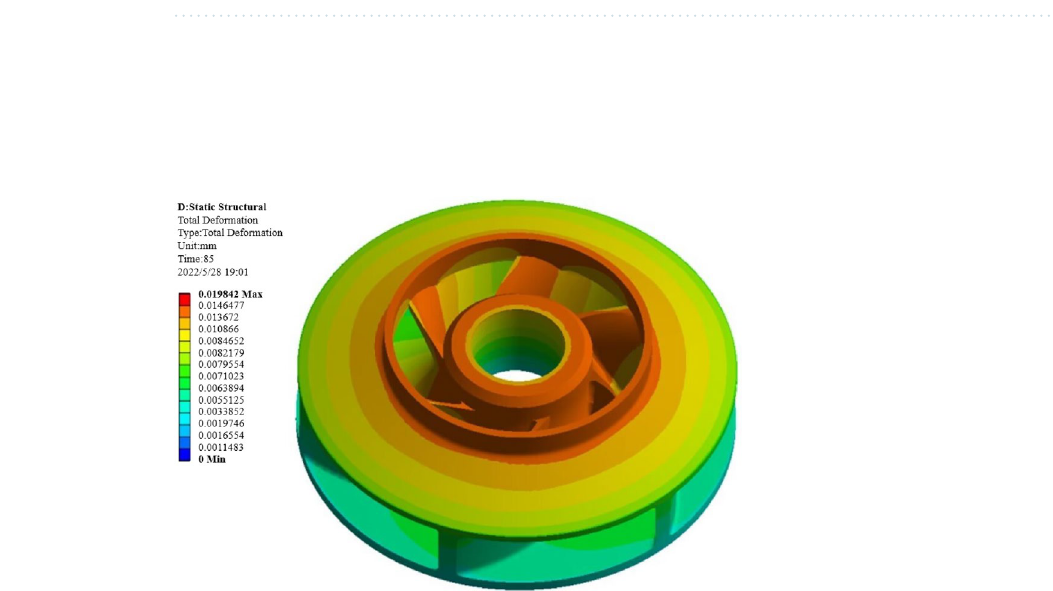
Figure 25. Expected values for a certain process parameter with good warpage and shrinkage.